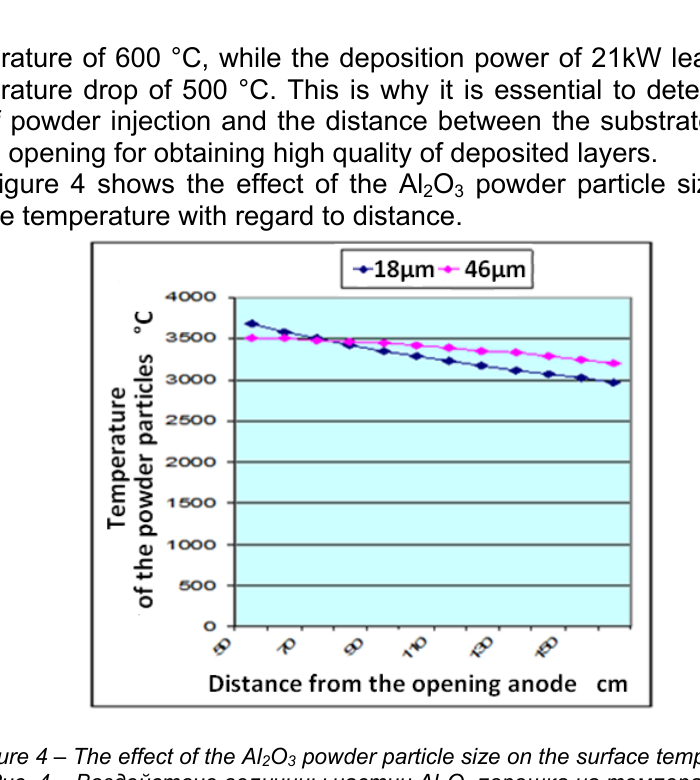
Figure 4 – The effect of the Al 2 O 3 powder particle size on the surface temperature Рис . 4 – Воздействие величины частиц Al 2 O 3 порошка на температуру поверхности Слика 4 – Утицај величине честица праха Al 2 O 3 на температуру